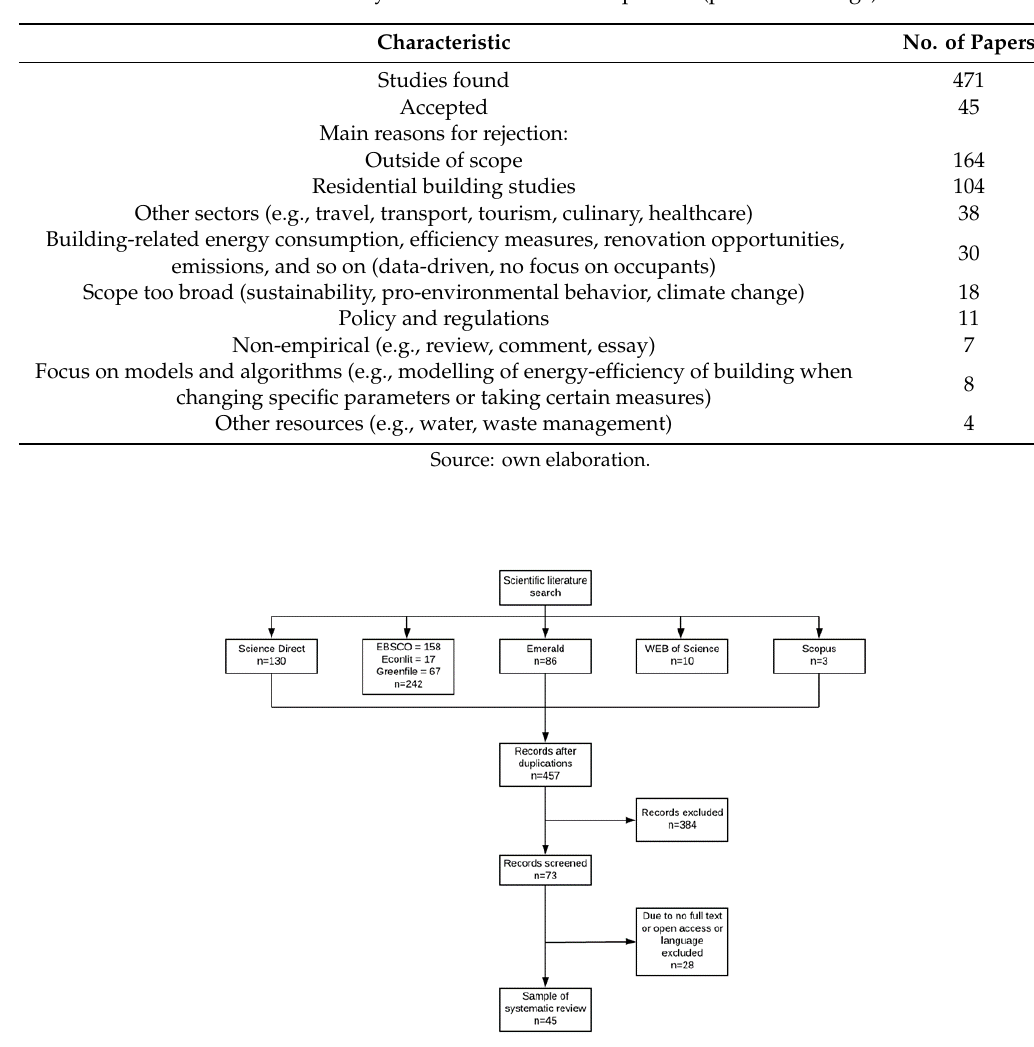
Table 2. Summary of search and selection process (public buildings).